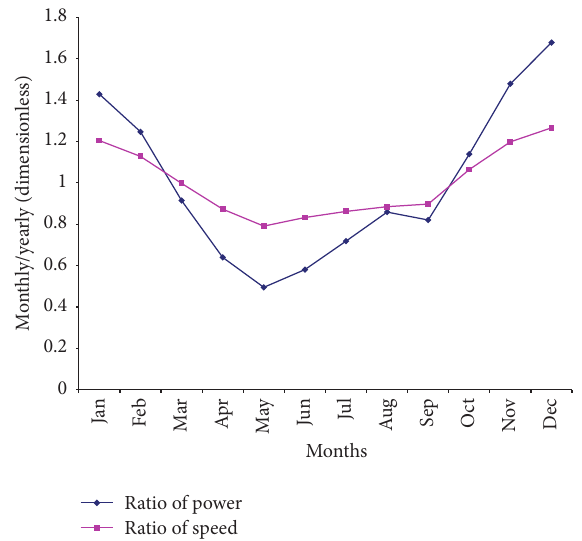
Figure 9: (Monthly/annual) ratio of mean wind power density and 10 m wind speed for the period 1980–2009 in the ECS.